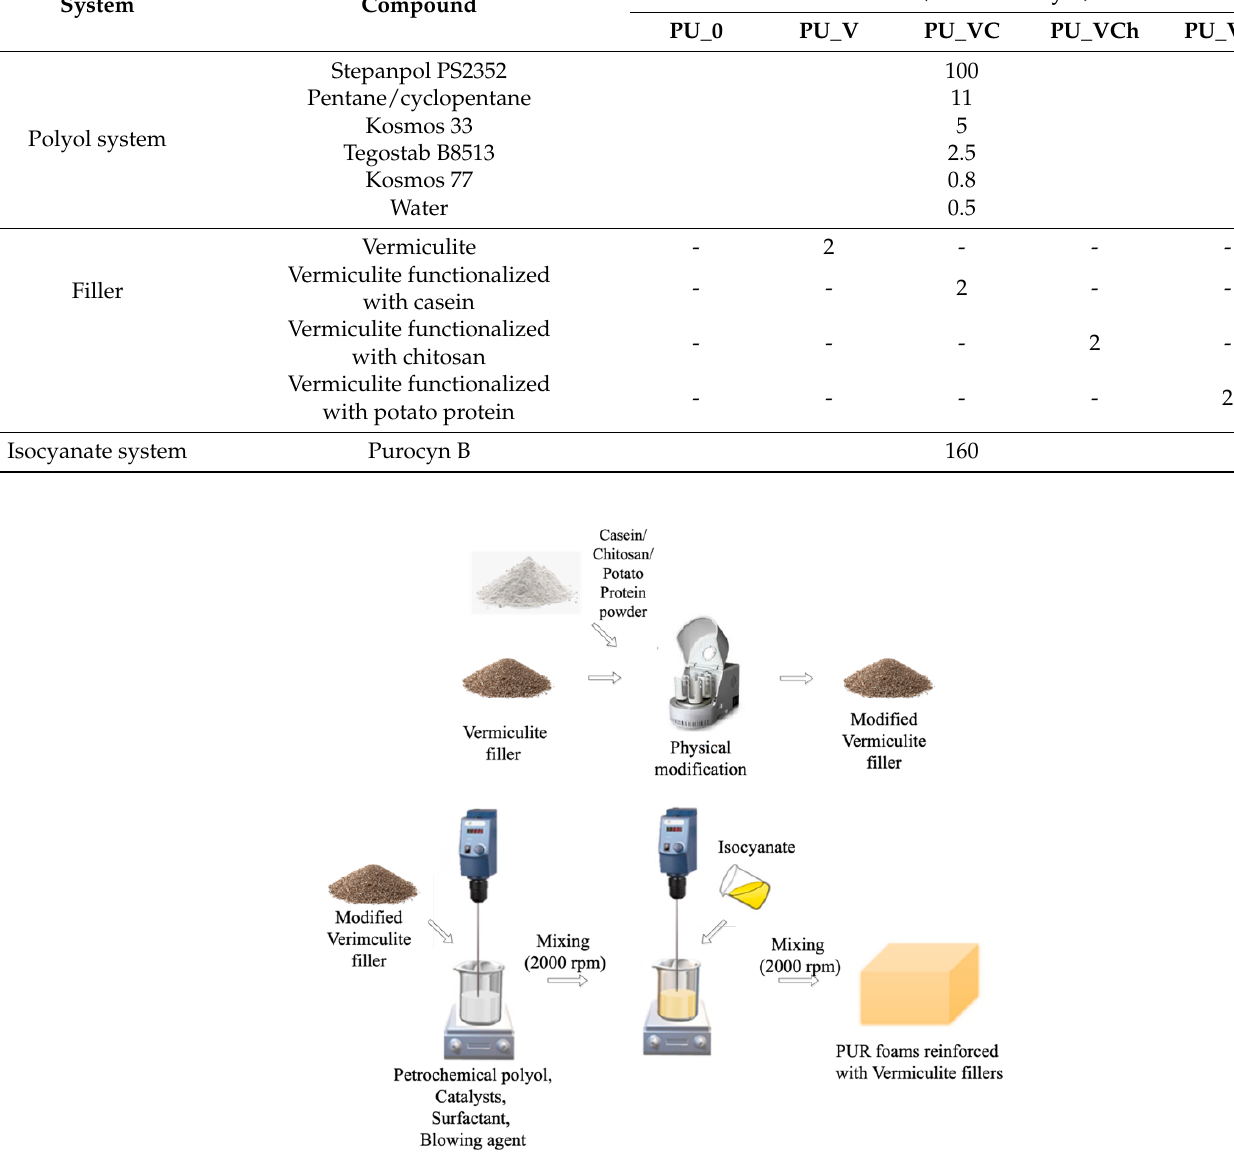
Figure 10. Schematic procedure of the synthesis of PU composites reinforced with vermiculite filler modified with casein/chitosan/potato protein.